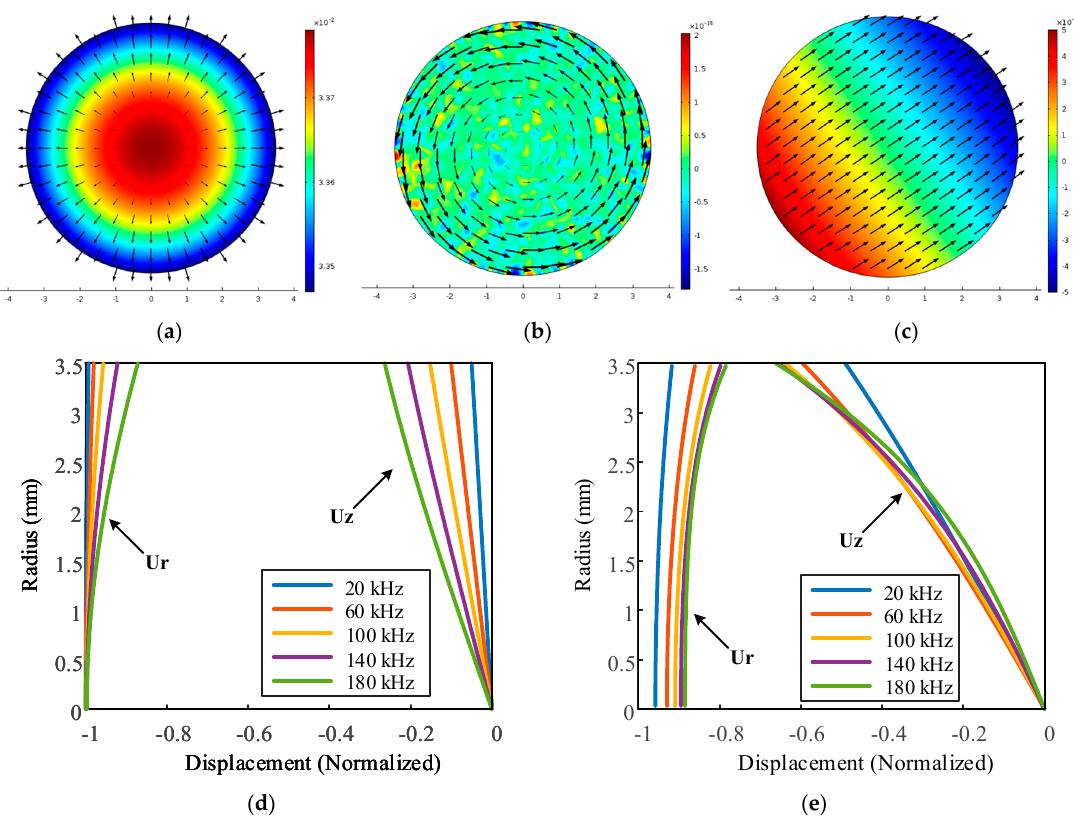
Figure 2. The vibration displacement distribution of ( a ) longitudinal, ( b ) torsional, and ( c ) flexural waves in a 7-mm-diameter steel wire. Wave structure of the ( d ) L(0,1) and ( e ) F(1,1) modes at different frequencies.